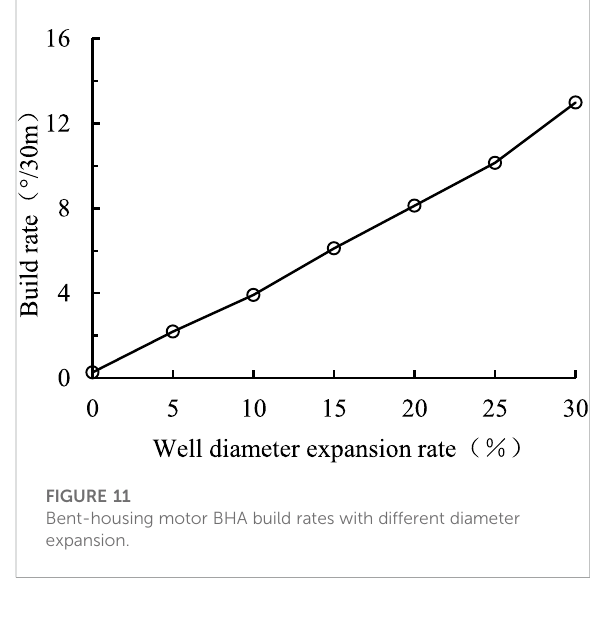
FIGURE 13 Effective anti-deviation distribution of pendulum BHA in uncertain parameter space.